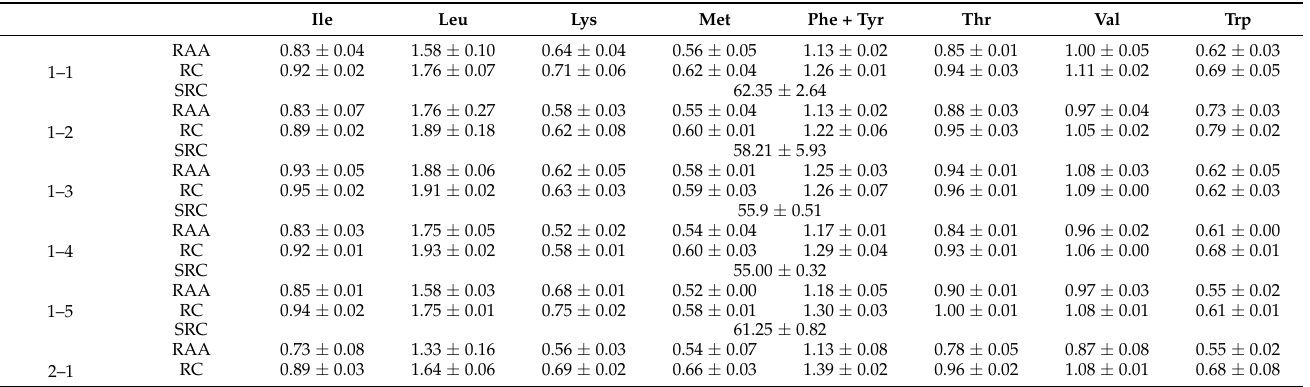
Table 10. RAA, RC, and SRC of FAO/WHO amino acid standard pattern spectra from three